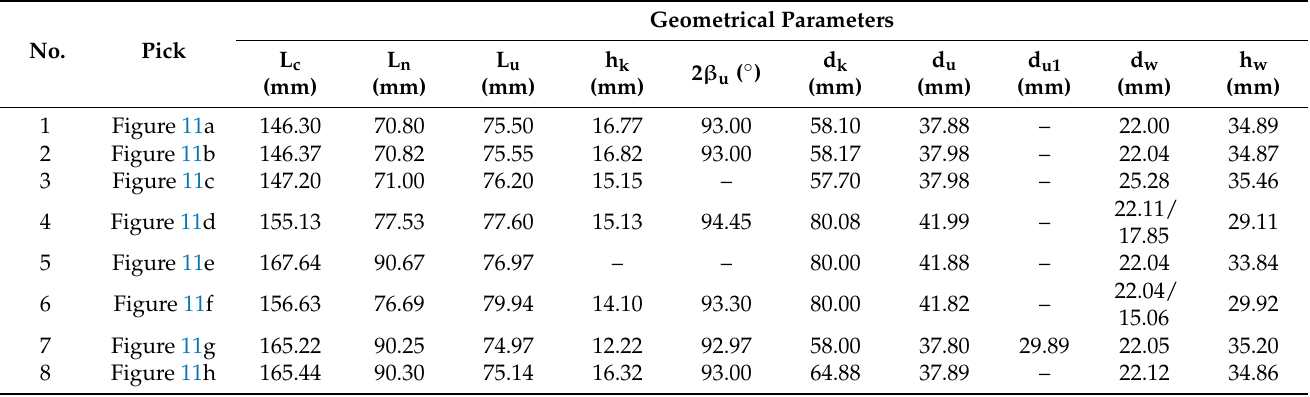
Table 1. Summary of linear and angular dimensions of the tested